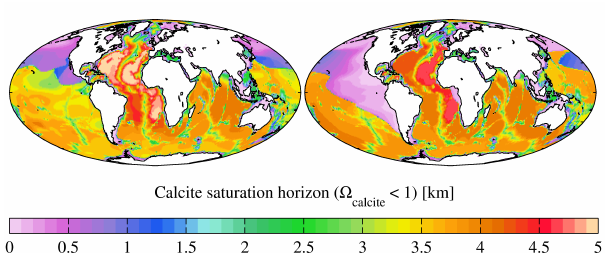
Fig. 20. Calcite compensation depth (CCD) as calculated from ob- servations (left) and M EDUSA -2.0 (right). The CCD is defined here as the depth at which carbonate ion concentration falls below the local saturation concentration, that is, where (cid:127) calcite falls below